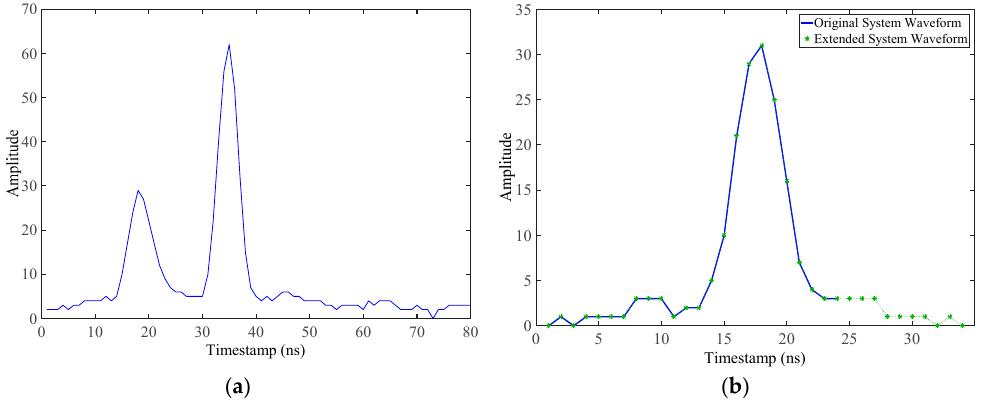
Figure 3. ( a ) A typical recorded waveform in the NSW dataset; and ( b ) its corresponding original system waveform.